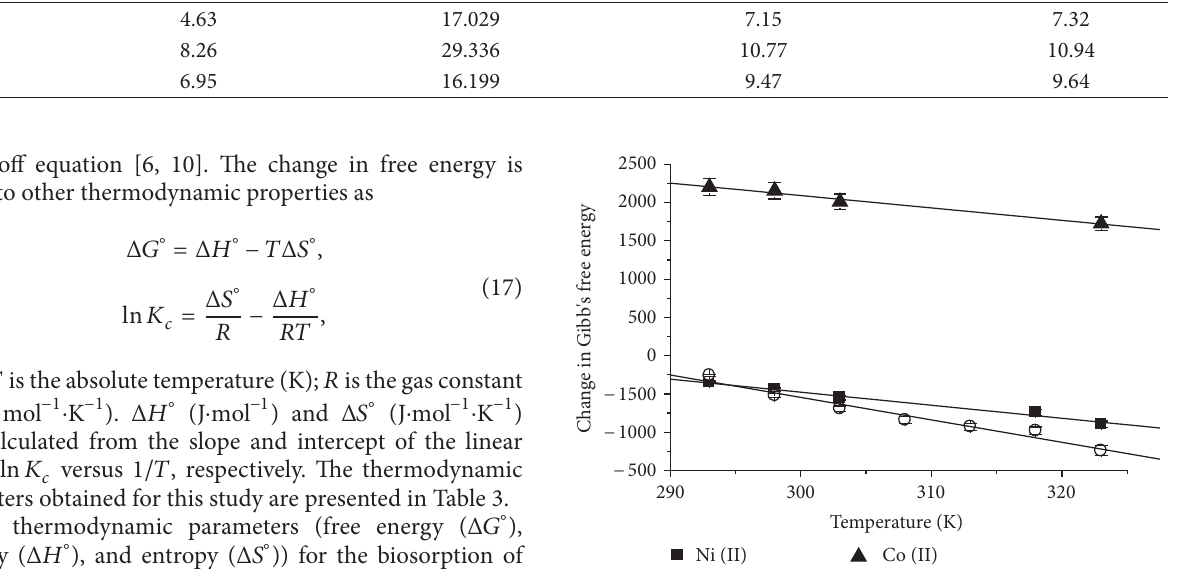
T 4: ermodynamic parameters for the biosorption of Ni(II), Cr(III), and Co(II) onto Acalypha hispida leaf. Metal ion